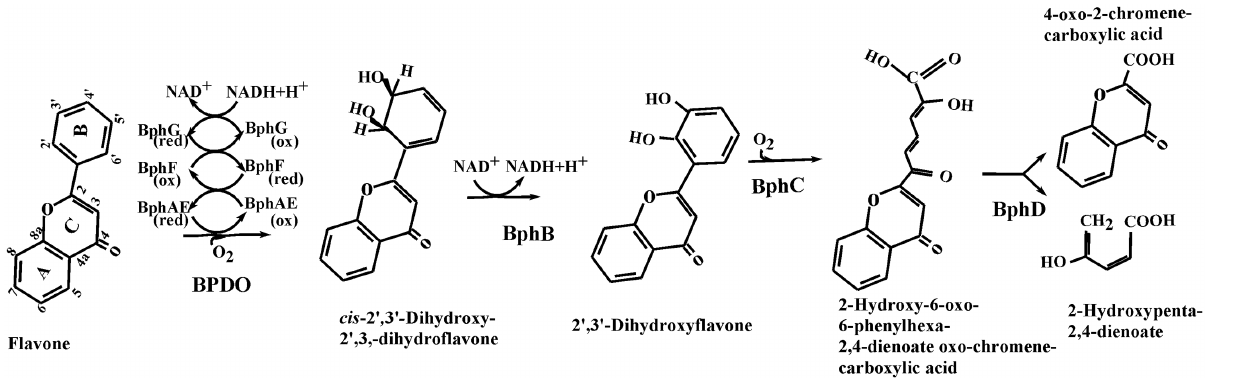
Fig 3. Proposed pathway for the production of 4-oxo-2-chromene carboxylic acid from flavone by strain U23A biphenyl catabolic enzymes. Data is based on metabolites detected in 18 h-old culture of strain U23A co-metabolically grown on sucrose plus flavone plus metabolites detected in resting cell suspensions of biphenyl-induced U23A cells incubated for variable periods of time with flavone.